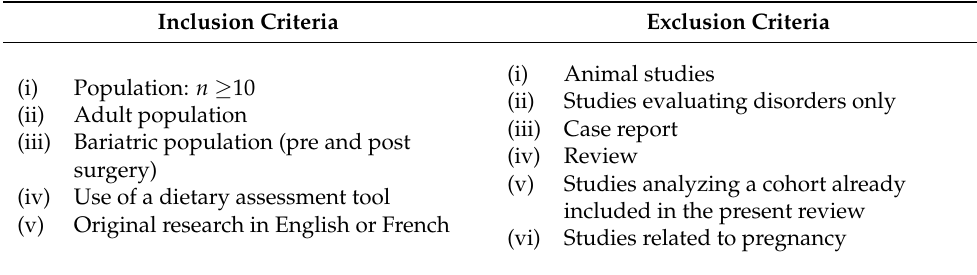
Table 1. Inclusion and exclusion